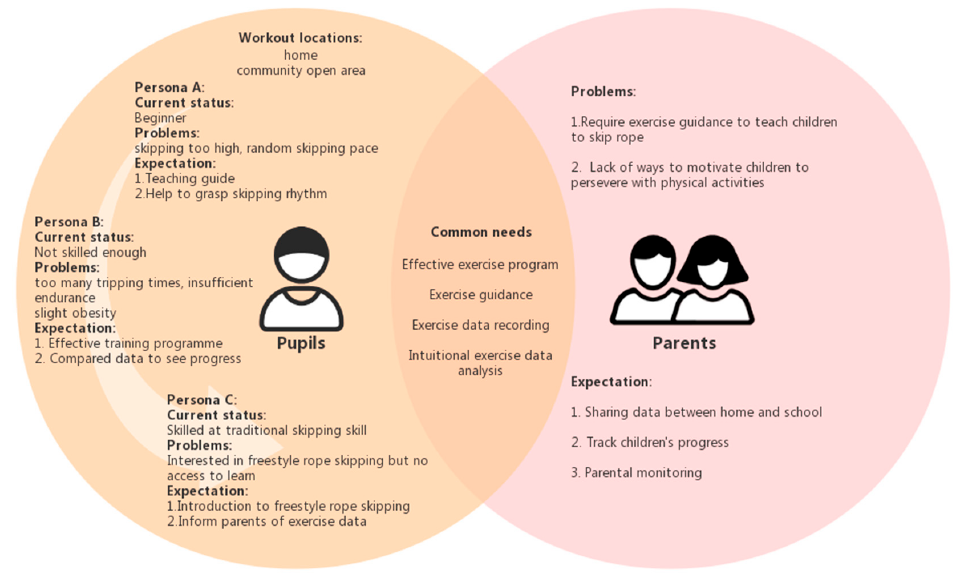
Figure 2. Personas of pupils and parents.